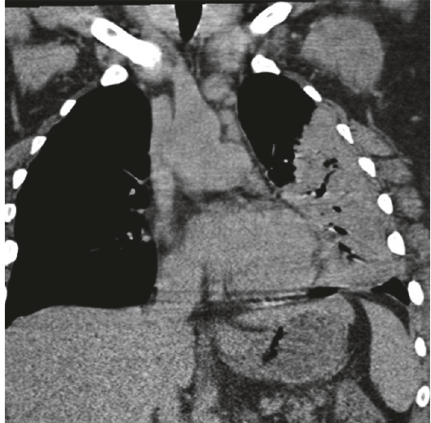
Figure3:CoronalsectionchestCTshowingconsolidationintheleft midzone with air bronchograms consistent with lobar pneumonia, without pleural